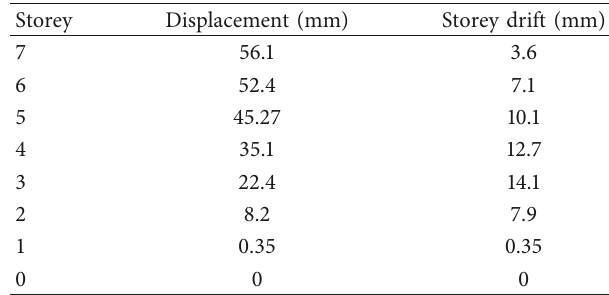
Table 6: Distribution of horizontal loads to different floor levels.